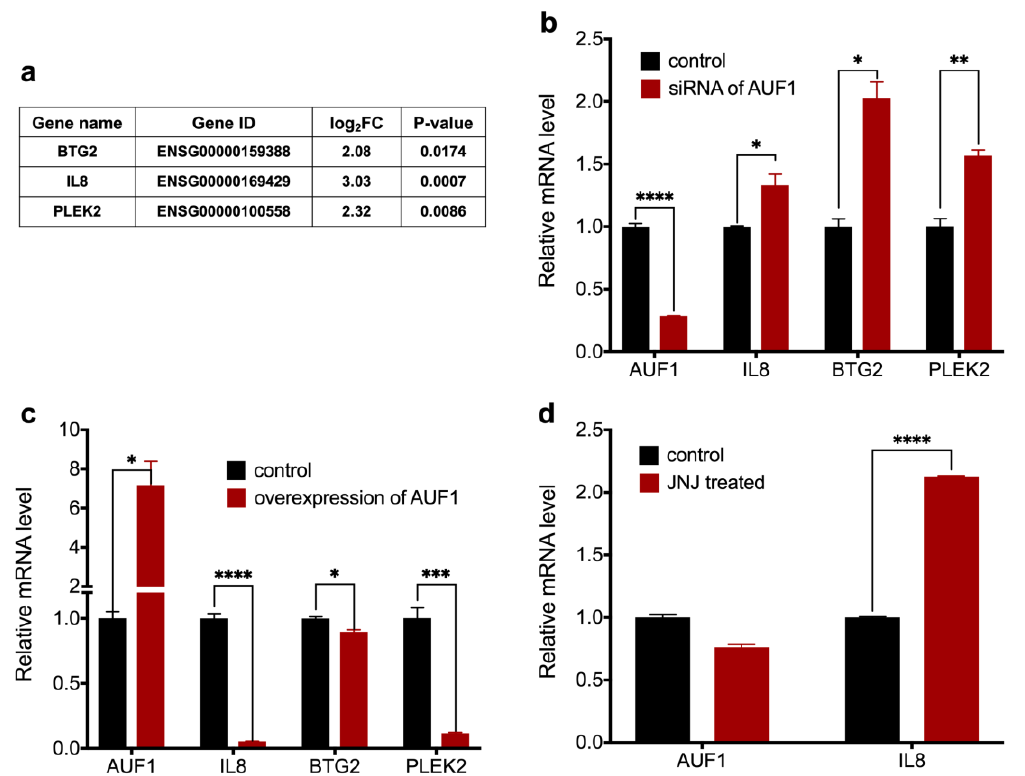
Figure 4. Identification of AUF-1e fand JNJ-7706621on of AUF-1e for . ( a ) Differentially expressed genes with the most significant difference combining the data in RNA-seq and RIP-seq. ( b ) The relative mRNA level of IL8, BTG2, and PLEK2 after knocking down the AUF1 gene using siRNA. The siRNA of AUF1 (80 nM) was transfected to SK-MEL-2 cells for 48 h. ( c ) The relative mRNA level of IL8, BTG2, and PLEK2 after overexpressing the AUF1 gene. The plasmid containing the p37AUF1 sequence (0.25 μ g) was transfected to SK-MEL-2 cells for 24 h. ( d ) The relative mRNA level of IL8 after treatment with JNJ-7706621 at 1.75 μ M for 24 h. Data are shown as means ± SEM of n = 3. * p < 0.05, ** p < 0.01, *** p < 0.005, **** p < 0.001. All experiments were parallelly repeated in